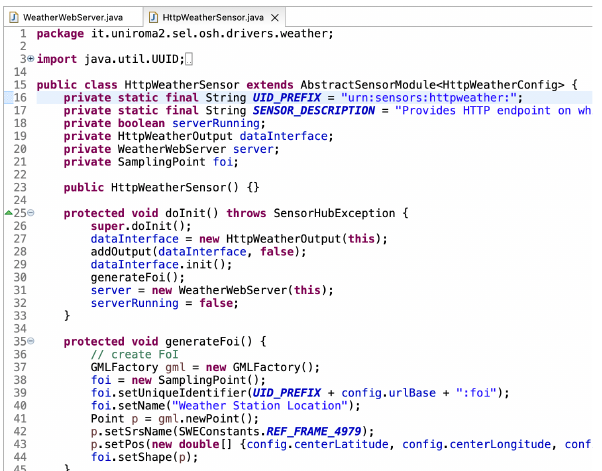
Figure 18. Fragment of the Weather Sensor Driver